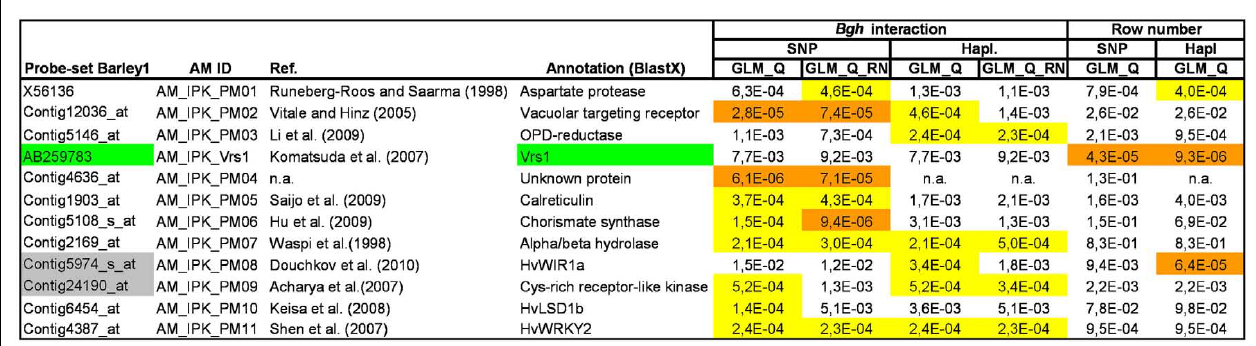
highlighted by gray shading are located within confidence intervals of QTLs for resistance to Bgh . Please note that HvWIR1a showing also significant association with RN mapped close to RN gene Vrs2 (Pourkheirandish and Komatsuda, 2007).Yellow and orange shading indicates significant association with Bonferroni-corrected p < 0.05 and p < 0.01, respectively. Only the most significant SNP and haplotype per candidate gene and model is shown.